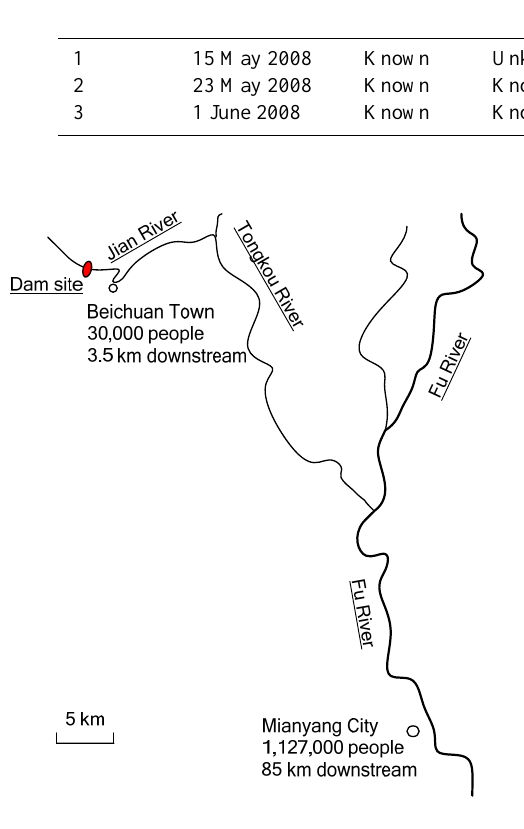
Fig. 2. Locations of the dam, Beichuan Town and Mianyang City.